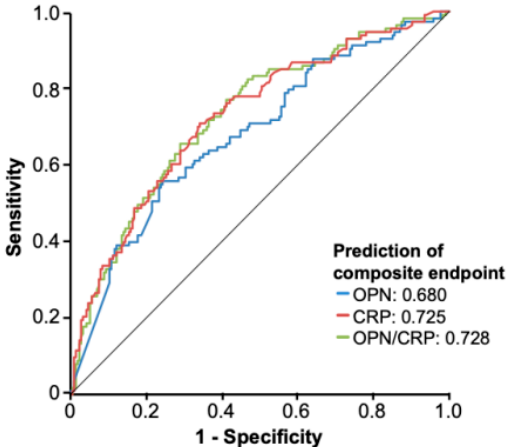
Figure 2. ROC curve analysis for the prediction of the composite endpoint. The combination of OPN and CRP serum levels has the highest accuracy for the prediction of the composite endpoint (either death, need for mechanical ventilation or need for renal replacement therapy). We finally performed time-to-event analyses for the composite endpoint. Kaplan– Meier curve analysis revealed a significantly better event-free survival for COVID-19 patients who presented with initial OPN levels within the lower tertile (Figure 3). Patients with circulating OPN levels in the upper tertile had a median event-free survival of only 6 days (Figure 3). The prognostic relevance of OPN upon hospital admission was further corroborated in a multivariate Cox-regression model. Here, OPN levels in the upper tertile turned out as an independent prognostic factor regarding event-free survival (HR: 1.834, 95% CI: 1.071–3.139, p = 0.027, Table 5). In addition, the patients’ BMI, eGFR, preexisting diabetes mellitus as well as circulating CRP levels were of prognostic relevance with respect to event-free survival (Table